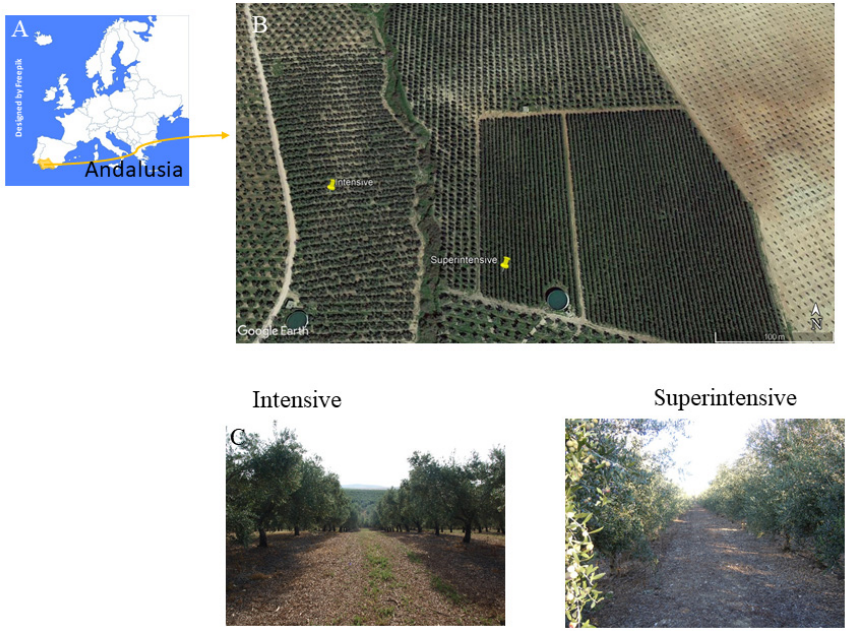
Figure 1. Location map ( A ), air view ( B ) and close view ( C ) of the two sampled olive orchards.